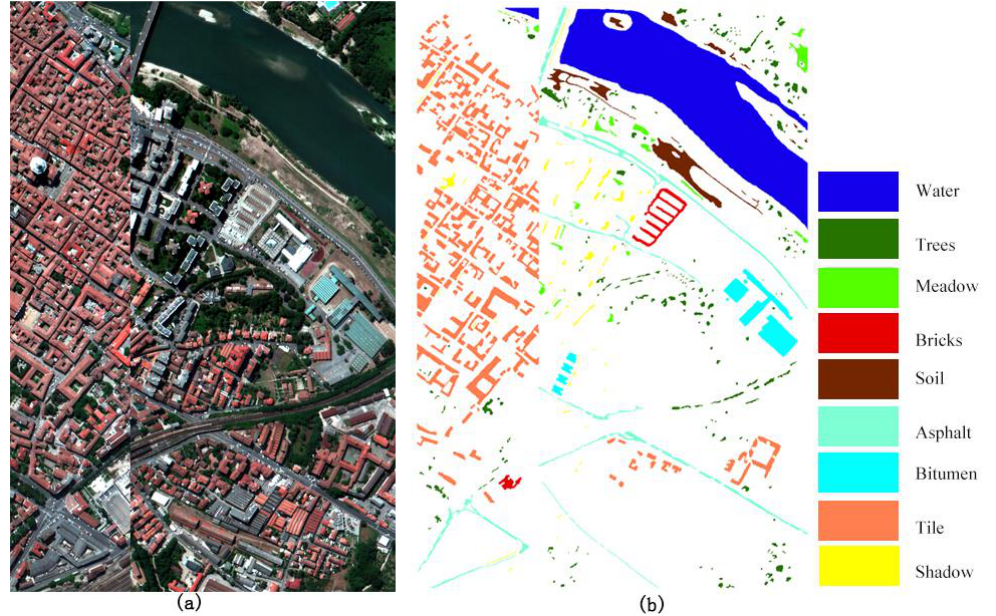
Figure 4. Pavia Center image used in the second experiment: ( a ) false color original image of Pavia Center and ( b ) ground reference data.